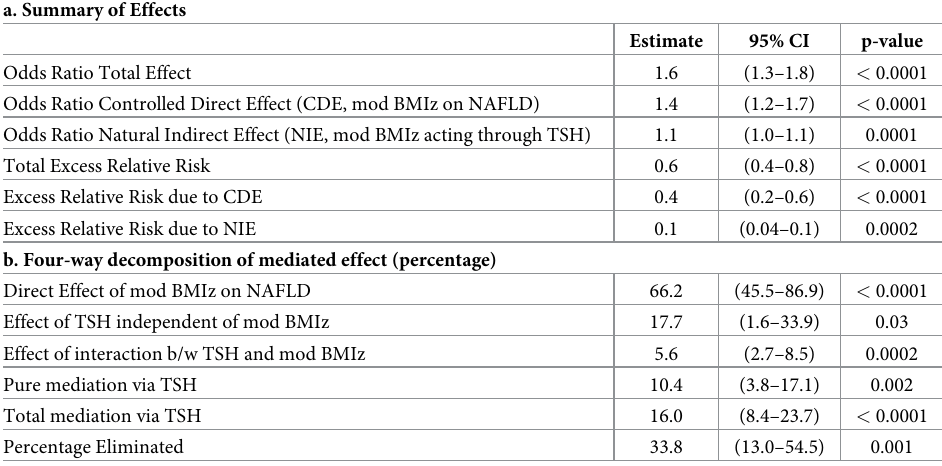
Table 3. Causal mediation analysis of TSH as a mediator of mod BMIz and NAFLD.